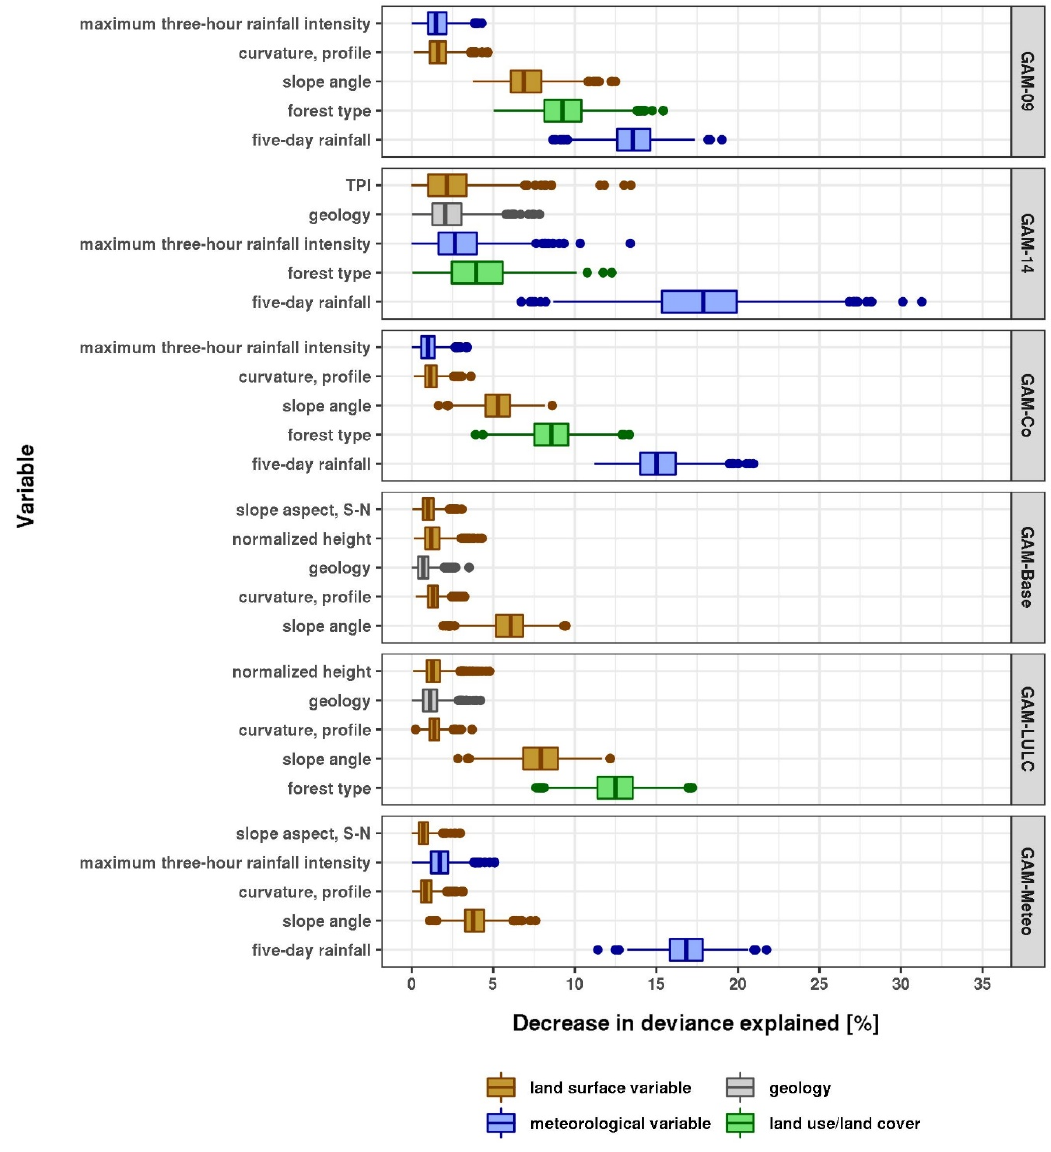
Figure 5. Variable importance using decrease in deviance explained [%]. Selection of top five most important variables sorted by mDD. For an overview of all input variables, refer to Table A7.